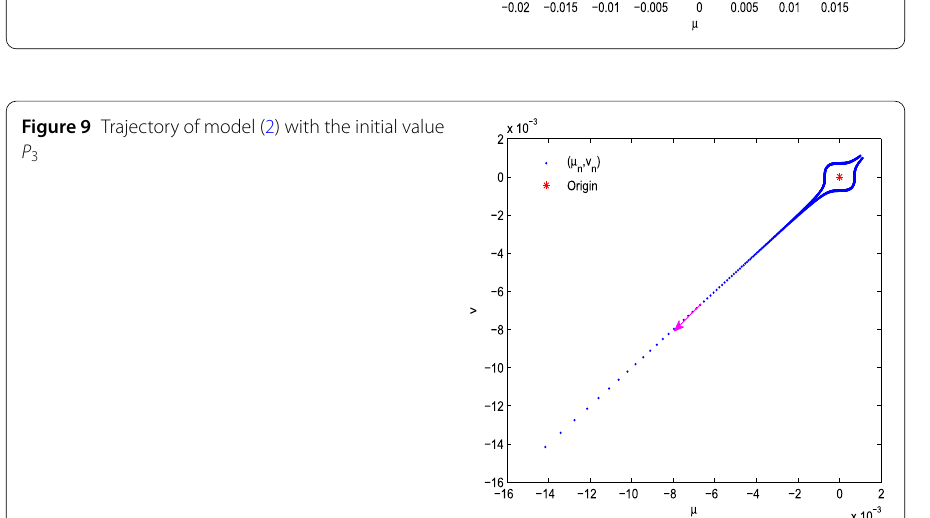
Figure 9 Trajectory of model (2) with the initial value P 3